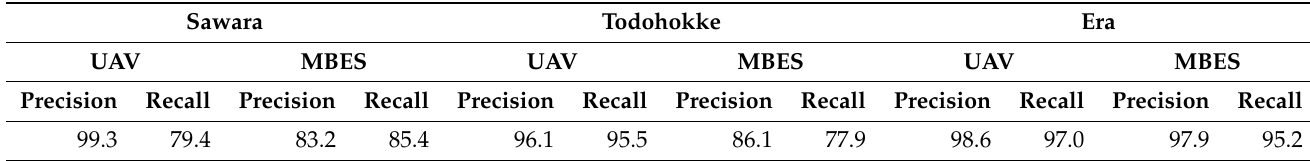
Table 3. Block-wise accuracy of block pose estimation for synthetic scenes. Only blocks with a <80% occlusion rate are considered of interest to retrieve. The metrics are precision (%) and recall (%) with a displacement error ≤ 0.1 × d max and rotation error ≤ 5 ◦ .